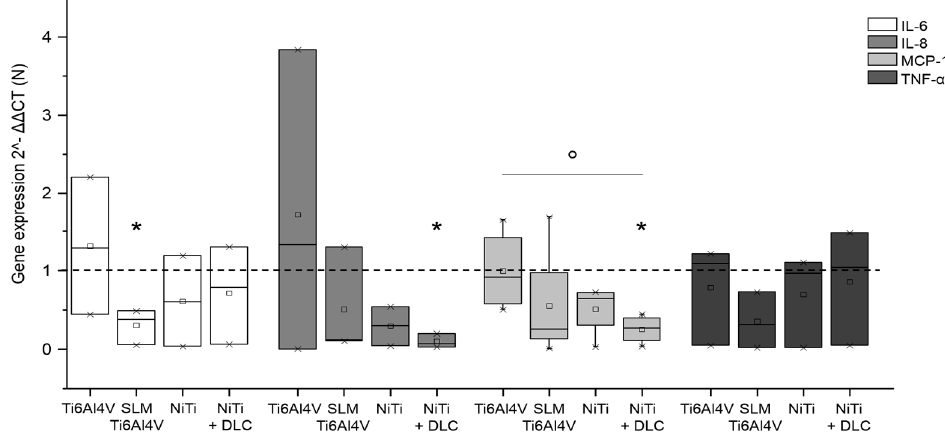
Figure 8. Gene expression (IL-6, IL-8, MCP-1, and TNF- α ) of human macrophages ( n ≥ 3) after 96 h of cultivation on several test pellets (forged Ti6Al4V, Ti6Al4V SLM, NiTi, and NiTi + DLC). Boxes denote interquartile ranges, horizontal lines within the boxes denote medians, and whiskers denote minimum and maximum values. Data are normalized to the growth control (=100%, dotted line). For statistical analysis, ANOVA was conducted. A p -value < 0.05 was considered statistically significant. Comparison to growth control: * p < 0.05. Comparison between several test pellets: ° p < 0.05.